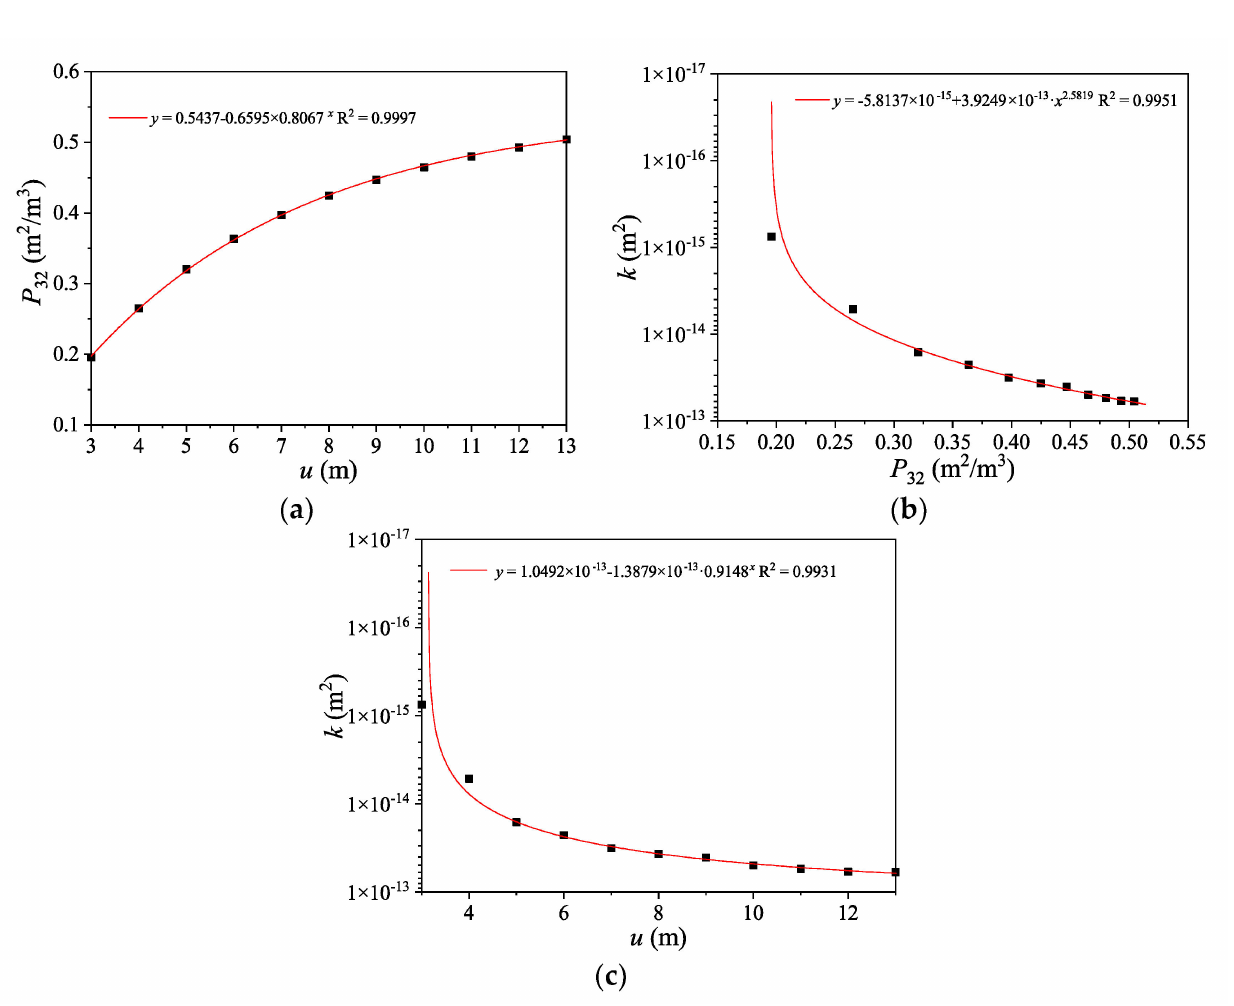
Figure 9. Relationships among P 32 , u, and k . ( a ) Relationship between P 32 and u ; ( b ) Variation in k with P 32 ; ( c ) Relationship between k and u